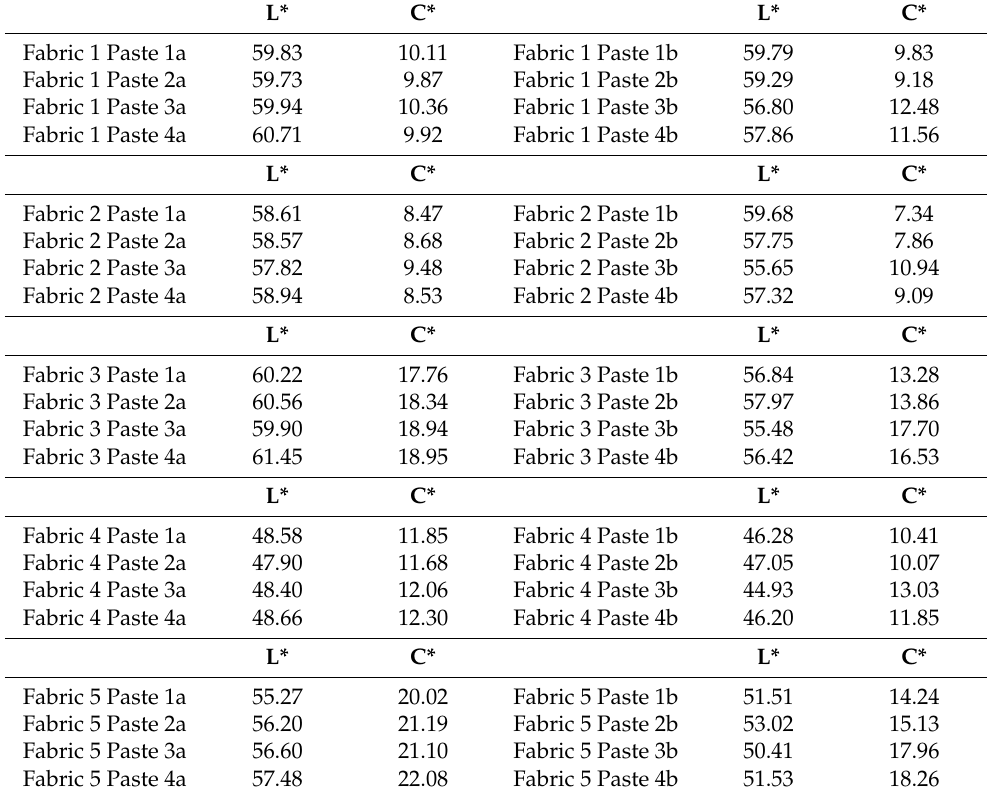
Table 7. Lightness (L*) and chroma (C*) relationship for printed samples. as definition of color